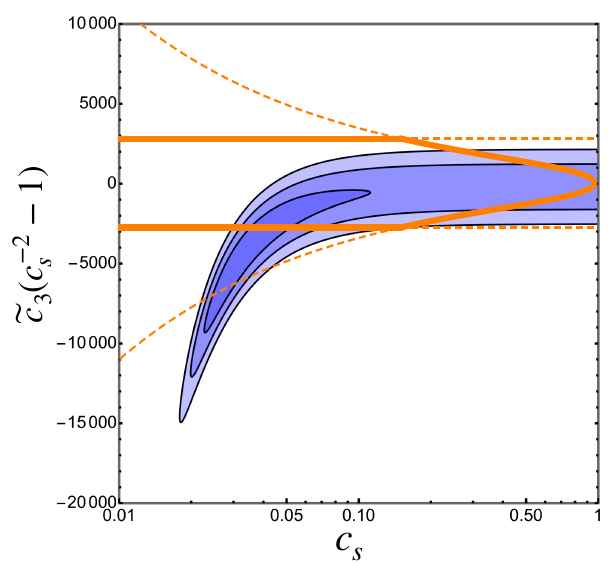
Figure 8 . The dark blue, blue, and light blue regions are the observationally allowed regions on the c s - ˜ c 3 ( c − 2 − 1) plane with the statistics of 1 σ , 2 σ , and 3 σ , respectively [100]. The orange s curve is a benchmark plot of the relation (4.20) for m = 30 H and Λ = 1000 H . The inside of the orange curve corresponds to m = 30 H and Λ > 1000 H . The cutoff scale is determined by Λ 6pt for c s < c ? ’ 0 . 15 , whereas Λ = Λ 5pt for c s > c ? ’ 0 . 15 s s